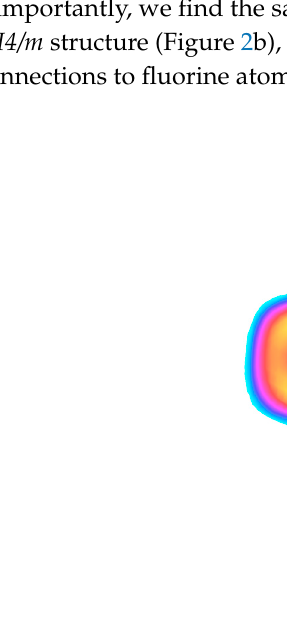
Figure 3. Pressure dependence of the enthalpy of formation per atom of various Kr m F n phases at 50, 80, 100, 140, 180 and 200 GPa. The compounds which stabilize at 80 GPa (Kr 6 F, Kr 4 F), 100 GPa (KrF) and 140 GPa (Kr 2 F) are marked together with KrF 2 and KrF 4 in the upper part of the graph; note that KrF 2 is predicted to decompose above 180 GPa.